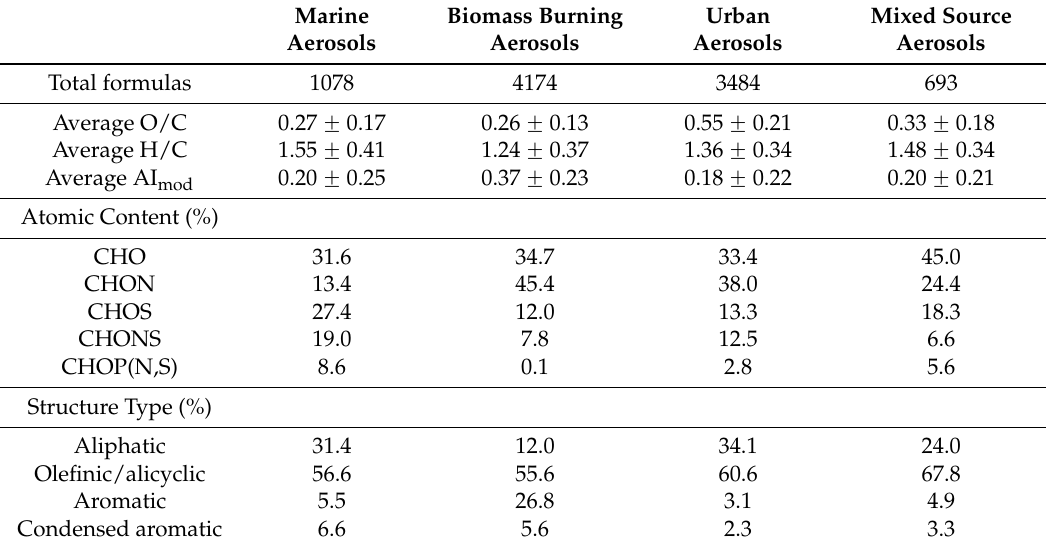
Distributions of formulas based on atomic content and AI mod structure type are listed as percentage